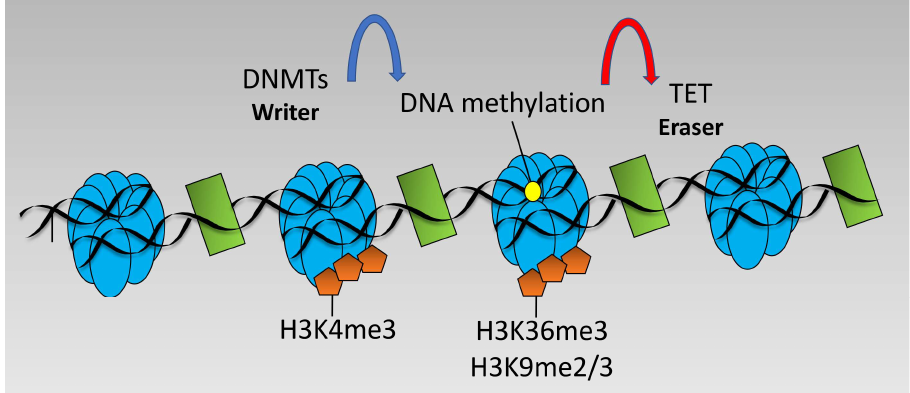
Figure 3. Dynamics of DNA methylation. DNA methylation is performed by DNA Methyl Transferases (DNMT) enzymes and removed by Ten-Eleven-Translocation (TET) enzymes. DNMTs target areas of unmethylated H3K4 and trimethylated H3K36 or di/trimethylated H3K9.